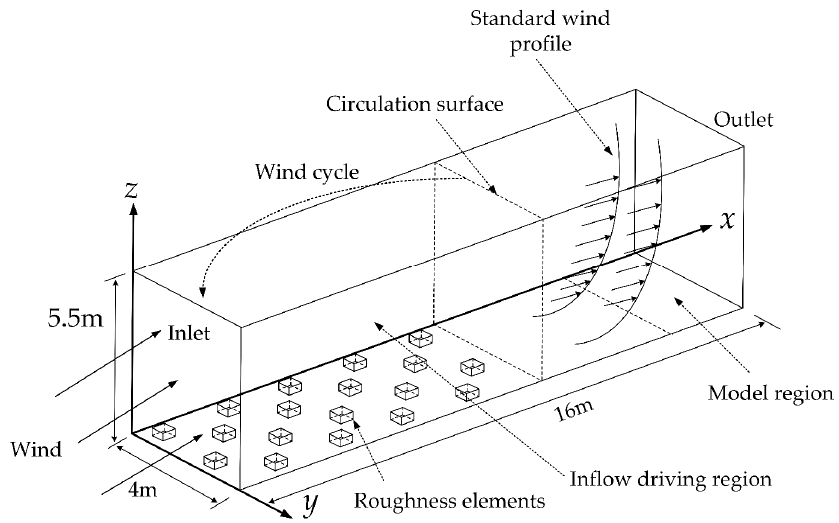
Figure 1. Schematic diagram of the calculation domain.